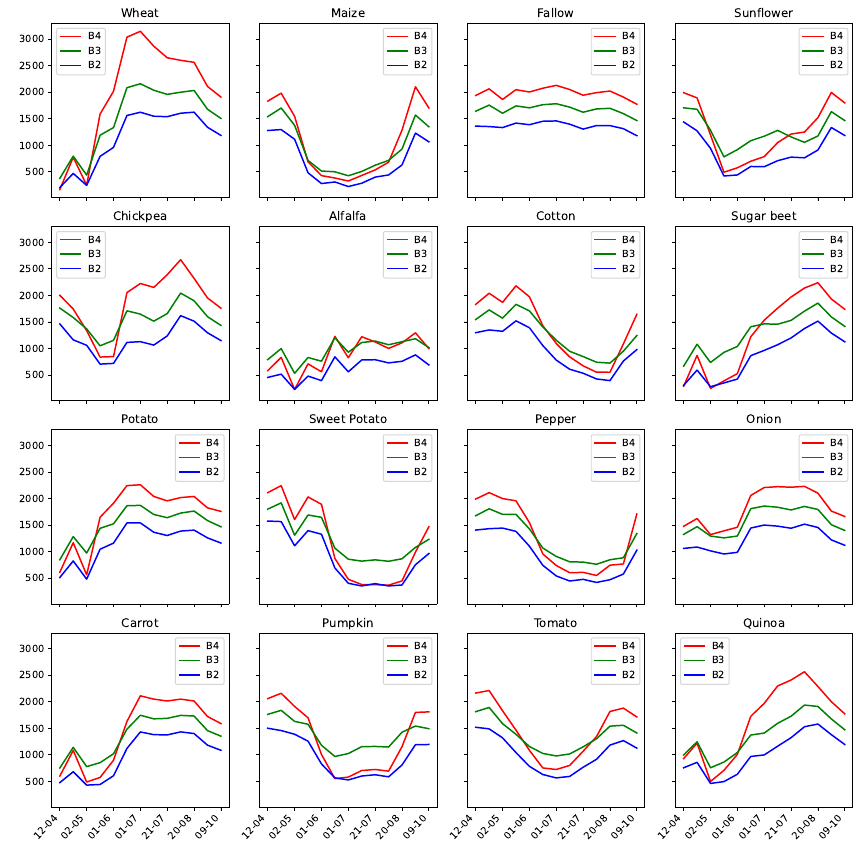
Figure 16. Average temporal profile, per available agricultural class, from Sentinel-2 visible light